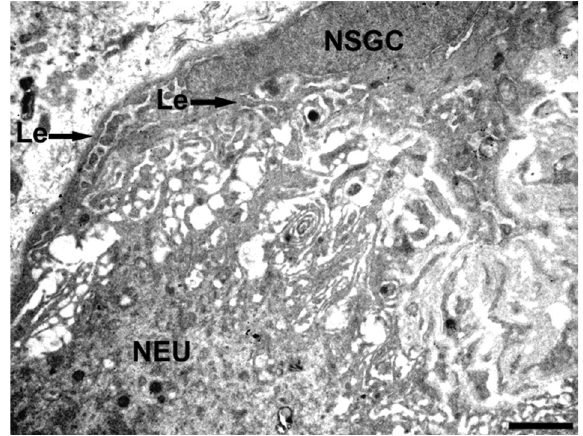
Figure 3. Cross-section of a Rana catesbeiana ’s dorsal root ganglion 3 days after sciatic nerve transection. Lamellar cytoplasmic expansions (Le) from the cytoplasm of a satellite glial cell (SGC) can be seen, spreading through the interstitial space toward the projections that depart from the neuronal body (NEU). Note chromatin condensation of the nuclear SGC (NSGC). Scale bar = 2 m